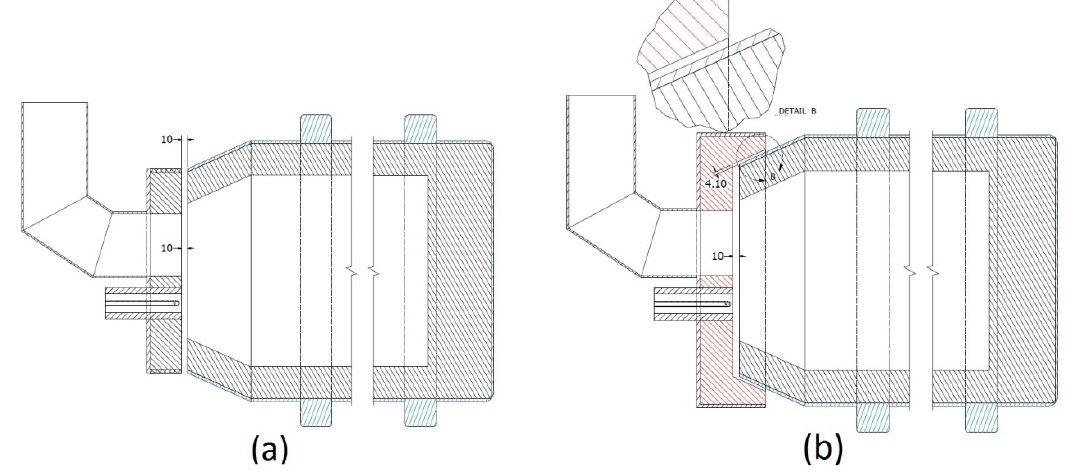
Figure 1. ( a ) Traditional design of door, ( b ) proposed design of door.